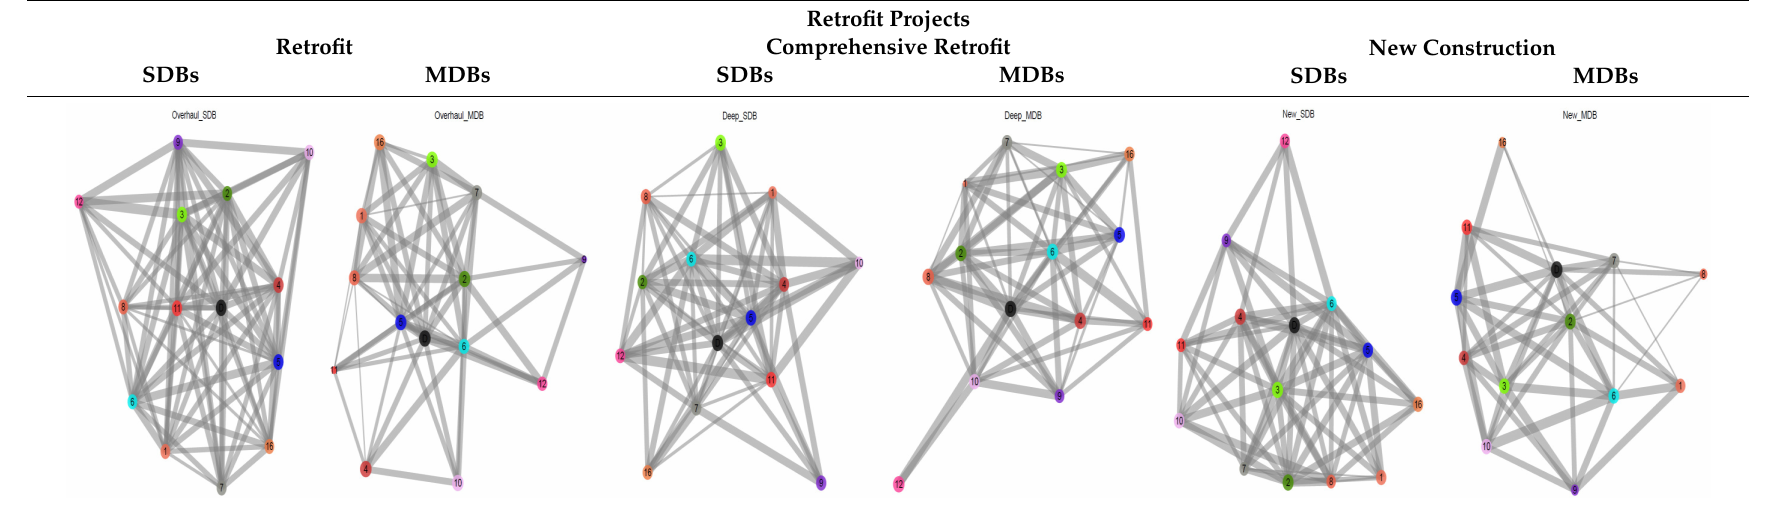
Table 8. Stakeholder level of power and interaction in the technology selection, classified according to building typologies and project types in France